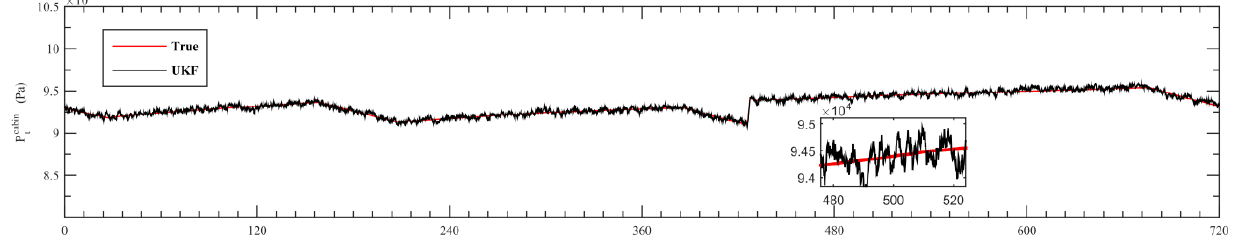
Figure 6. Comparison of true value and estimated value of total pressure in cabin.